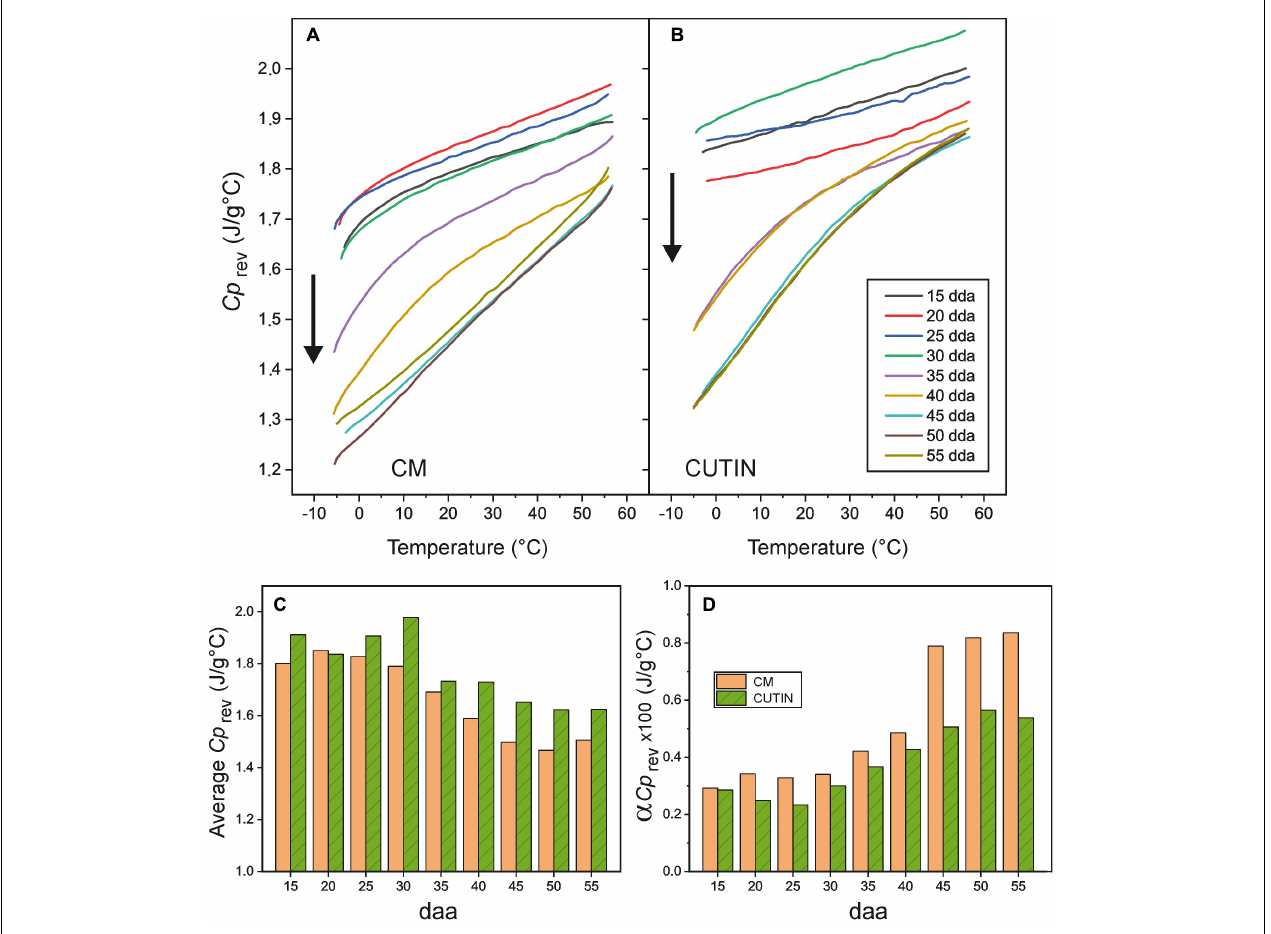
FIGURE 6 | Reversible heat capacity values ( Cp rev ) for (A) cuticle membranes and (B) cutins of tomato fruit in the (–5 to 55 ◦ C) temperature interval. Arrows highlight the curve evolution with daa time. (C) Average heat capacity values in the (0–50 ◦ C) interval and (D) slope of the linear region of the curves ( α Cp rev ) for CMs and cutins along fruit growth and